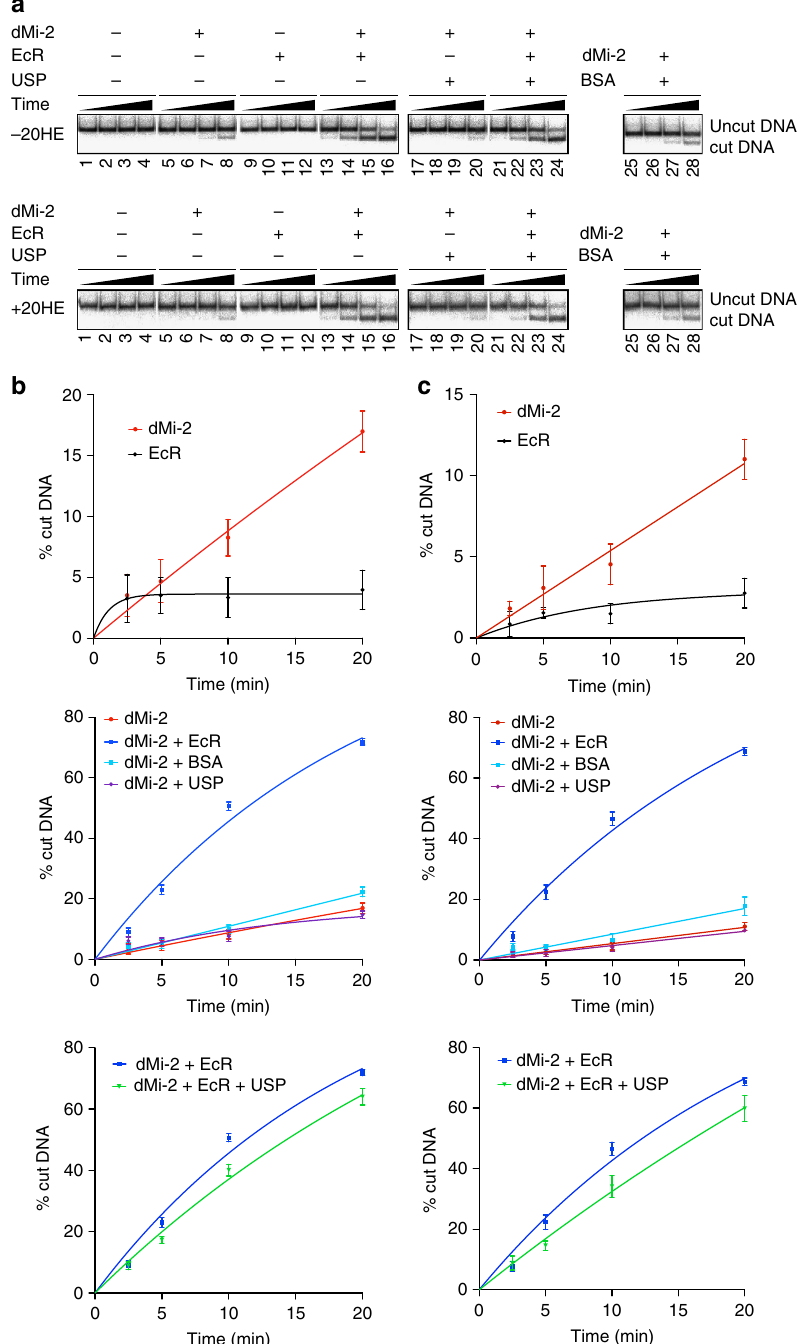
Figure 6 | EcR increases dMi-2-mediated nucleosome remodelling in vitro . ( a ) REA assays were carried out with a 32 P-labelled mononucleosome substrate in the presence of recombinant dMi-2, EcR, USP and BSA as indicated on top. Reactions were stopped at four time points (2.5, 5, 10 and 20min) and analysed by non-denaturing PAGE and autoradiography. The positions of the uncut DNA fragment and the cut DNA fragment (product of the remodelling reaction) are indicated on the right. The top panel shows REA assays carried out in the absence ( (cid:2) 20HE), the bottom panel shows REA assays carried out in the presence of 1 m M ecdysone ( þ 20HE). ( b , c ) REA assays were carried out in the presence of 110nM dMi-2, 110nM EcR, 445nM USP and/or 745nM BSA for 2.5, 5, 10 and 20min as indicated. Panel ( b ) shows results obtained in the absence of ecdysone; panel ( c ) shows results obtained in the presence of 1 m M ecdysone. Bands containing cut and uncut DNA were quantified using the Science Lab Image Gauge (FUJIFILMS) software. The ratio of cut and total DNA (cut plus uncut) is plotted as ‘% cut DNA’. Curves were fitted using the GraphPad Prism software according to one-phase decay equation. Error bars represent s.e.m. and are derived from four ( b ) and three ( c ) independent fragment cleavage indicating nucleosome remodelling (Fig. 6a, top panel: lanes 9–12; Fig. 6b, top panel). However, addition of top panel: lanes 5–8; Fig. 6b, top panel). In contrast to dMi-2, EcR to dMi-2 resulted in significant stimulation of remodelling EcR on its own did not remodel the nucleosome (Fig. 6a, (Fig. 6a, top panel: lanes 13–16; Fig. 6b, middle panel). By